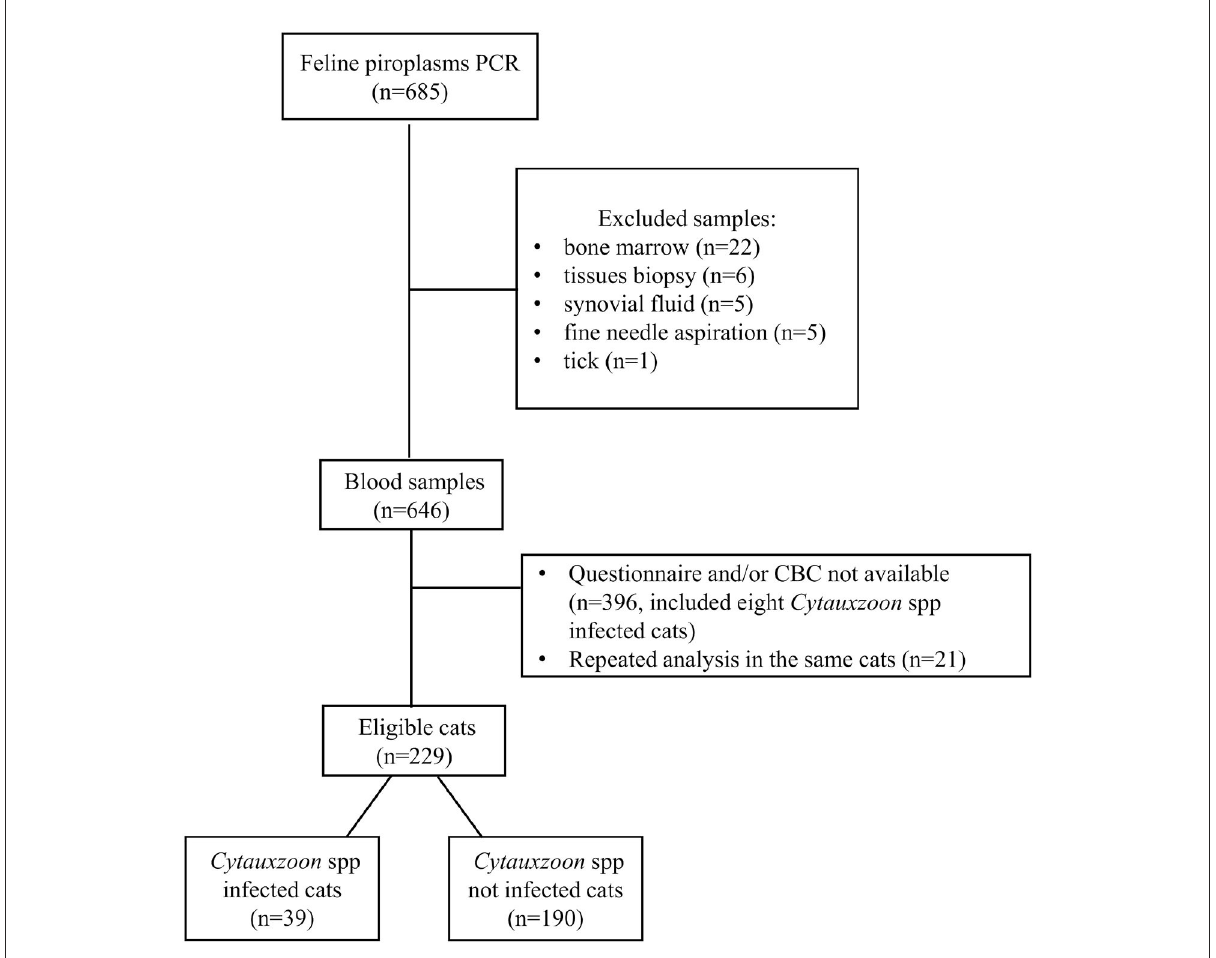
FIGURE1 Diagram of the selection of the cats included in the study.